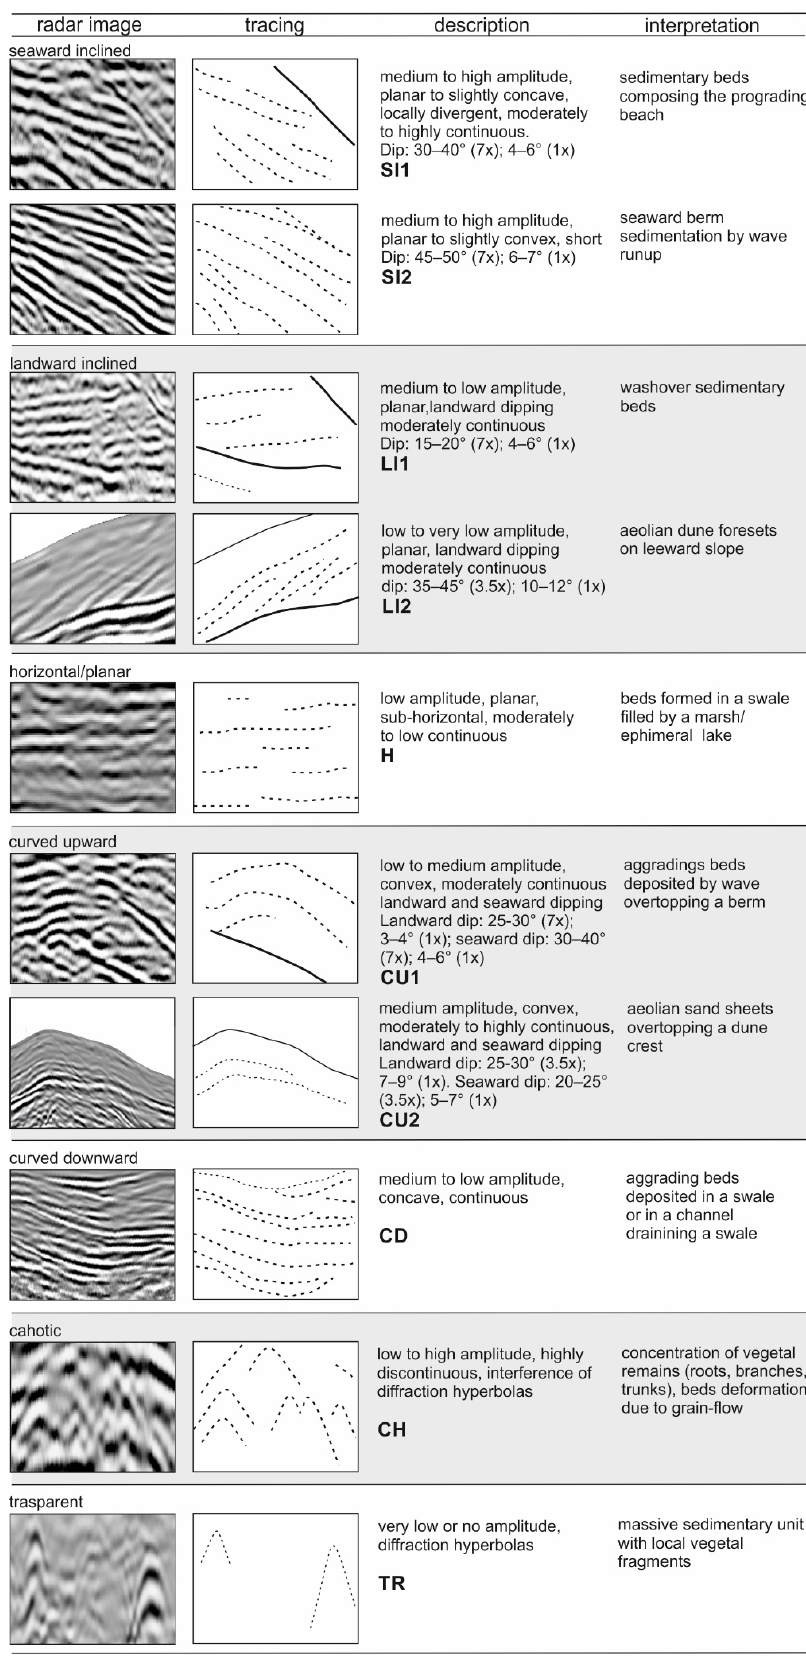
Figure 5. GPR image, reflections tracing and interpretation of the radar facies.